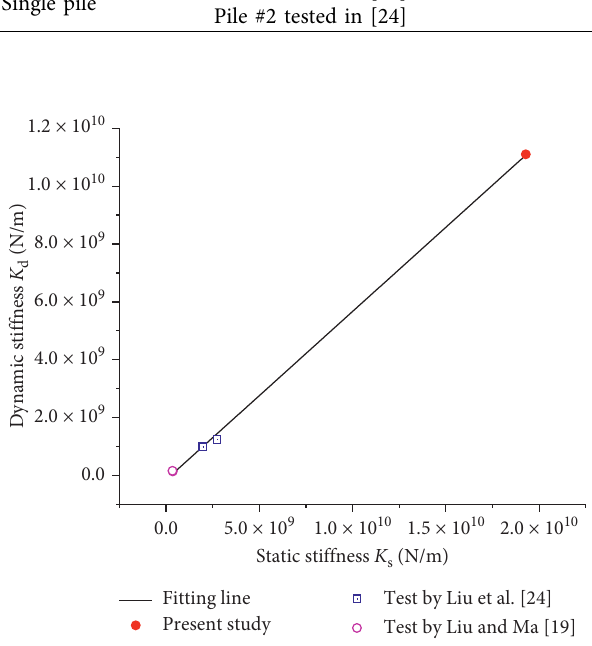
Figure 15: Comparison of dynamic and static